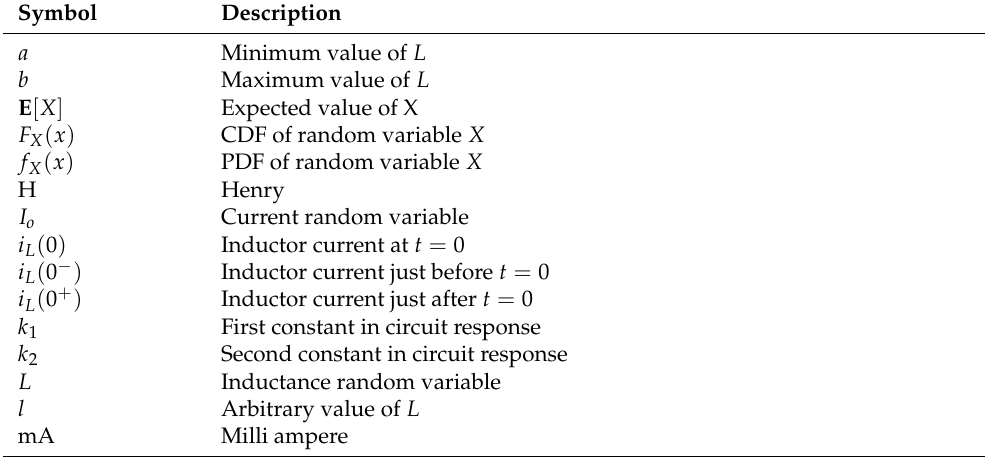
Table 1. Symbols and